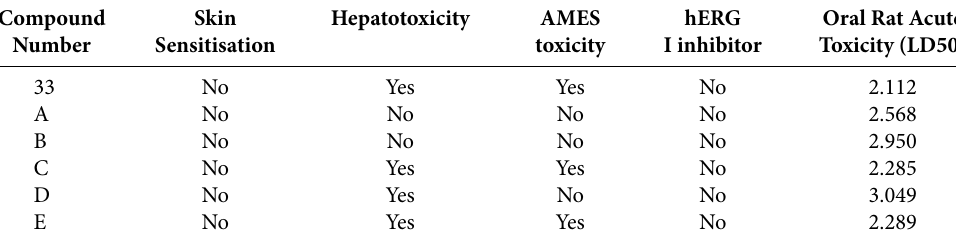
Table 8. Toxicty prediction for new inhibitors